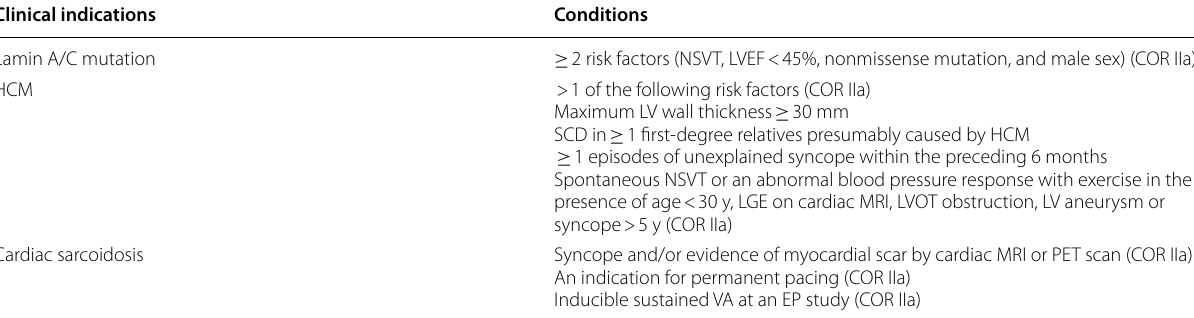
ICD implantable cardioverter-defibrillator, HFpEF heart failure with preserved ejection fraction, NSVT non-sustained ventricular tachycardia, COR class of recommendation, EP electrophysiology, LVEF left ventricular ejection fraction, SCD sudden cardiac death, HCM hypertrophic cardiomyopathy, LGE late gadolinium enhancement, MRI magnetic resonance imaging, LVOT left ventricular outflow tract, PET positron emission tomography, VA ventricular arrhythmia